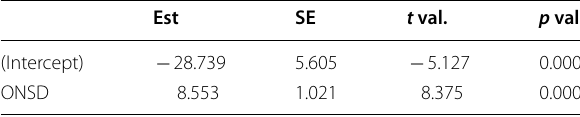
Table 3 For each increase of 1 mm of ONSD there was an average increase of 8553 mmHg in ICP